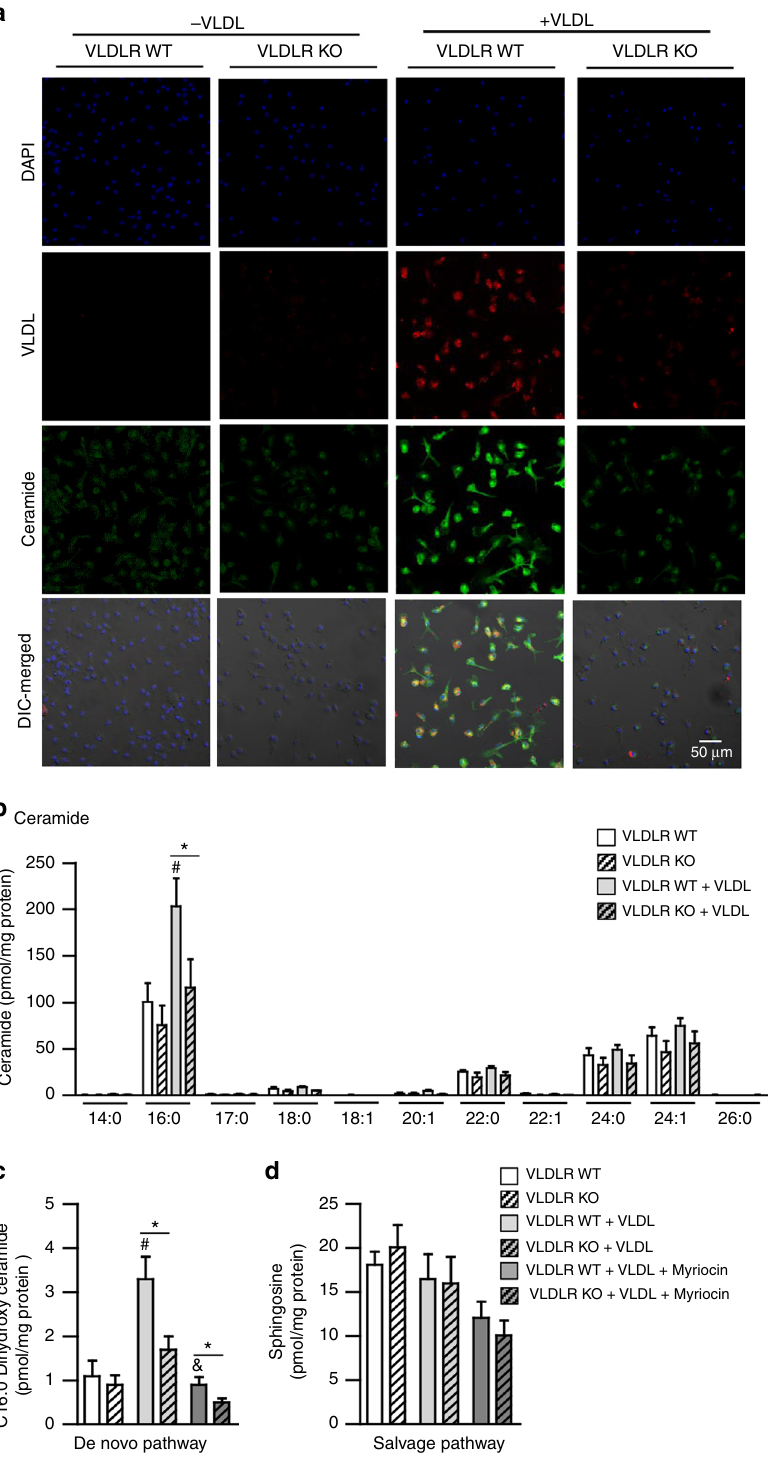
Fig. 5 The level of C16:0 ceramides is elevated through VLDL – VLDLR axis in macrophages. a Microscope imaging analysis of the nucleus (blue), VLDL-Dil (red), ceramides (green), and DIC-merged of WT or VLDLR KO BMDMs with or without VLDL (30 μ g/ml). b Lipid pro fi le analysis was performed in BMDMs from WT or VLDLR KO mice with or without VLDL incubation. c , d The levels of C16:0 dihydroxy ceramides and sphingosines were measured in WT or VLDLR KO BMDMs with or without VLDL (30 μ g/ml) or myriocin (10 μ M). Data represent mean ± SD. # P < 0.05 vs. VLDL, & P < 0.05 vs.